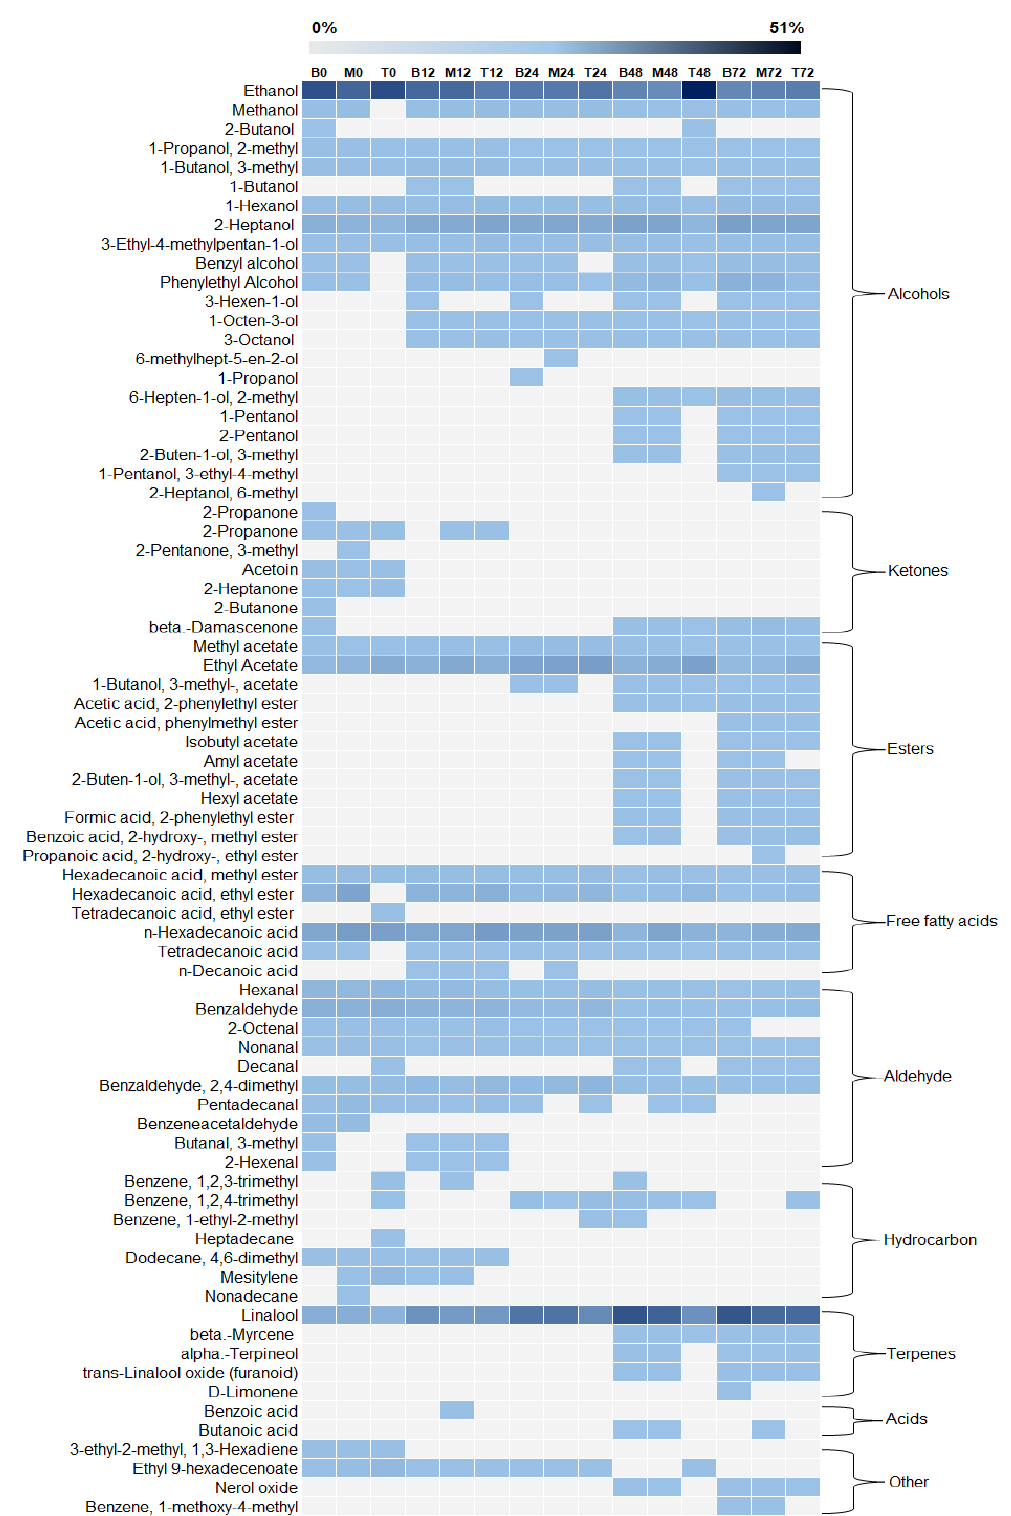
Figure 4. Heatmap of the volatile compounds identified in the bottom (B), middle (M), and top (T) layers. The number after each letter represents the fermentation time (e.g., B0 = bottom layer at 0 h).